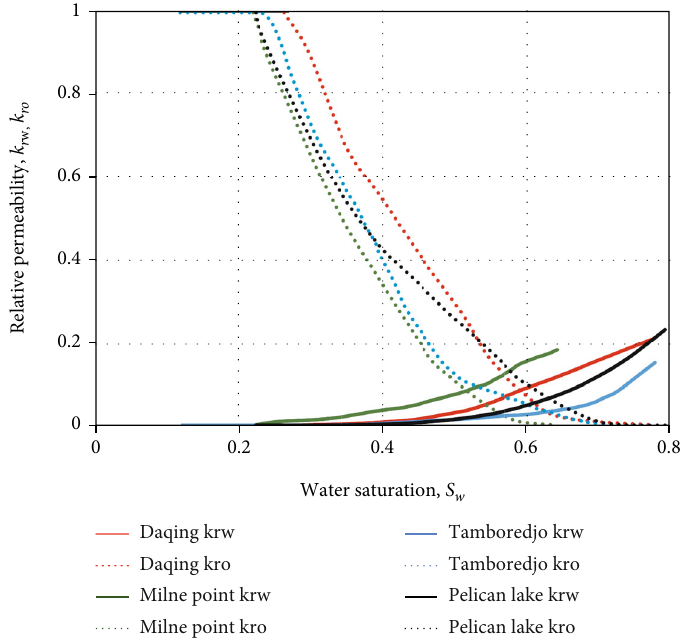
Figure 6: Relative permeability curves used in simulations after smoothing. Table 1: General property of simulation area for the four oil fi elds.